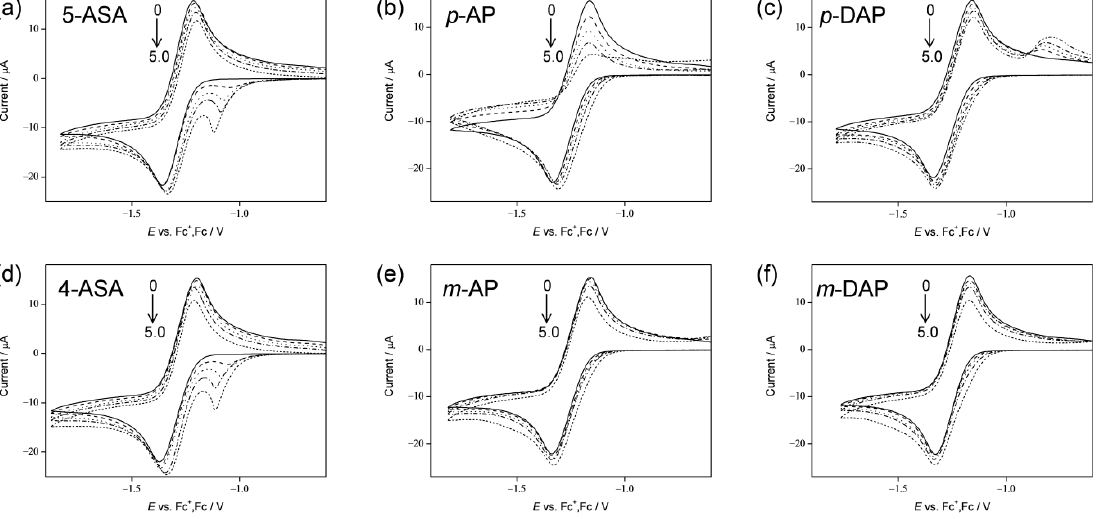
Figure 2. Cyclic voltammograms for 4.8 × 10 − 3 mol dm − 3 O 2 in the presence of ( a ) 5-ASA, ( b ) p -AP, ( c ) p -DAP, ( d ) 4-ASA, ( e ) m -AP, and ( f ) m -DAP in DMF containing 0.1 mol dm − 3 tetrapropylammonium perchlorate (TPAP) recorded with a glassy carbon electrode at a scan rate of 0.1 V s − 1 . Concentrations ( × 10 − 3 mol dm − 3 ) are 0, 1.0, 2.0, 3.0, and 5.0. The concentration changes are indicated by arrows.